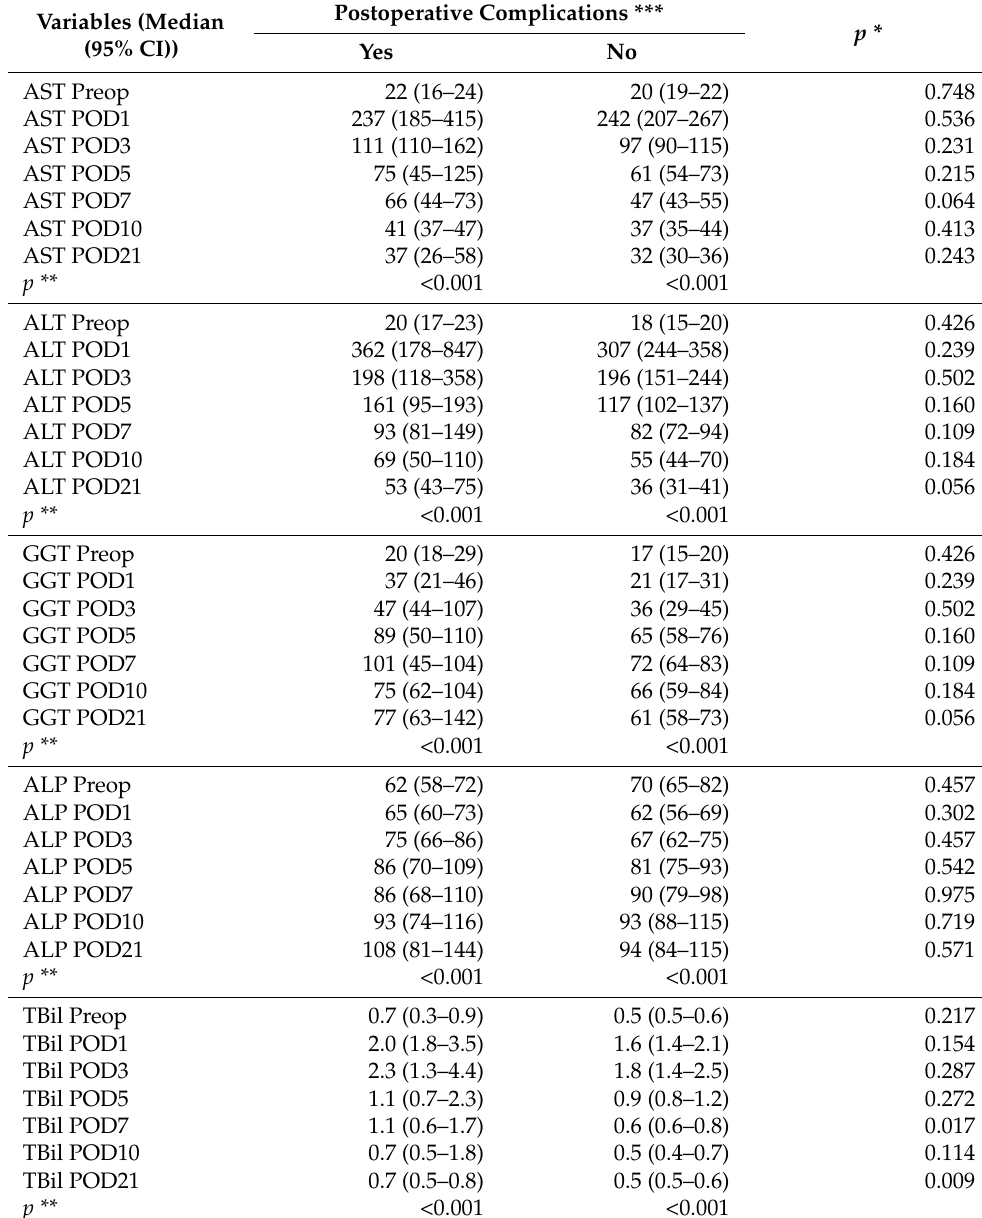
Table 5. Comparison of the study subgroups created according to the postoperative complications status in terms of routine biochemical